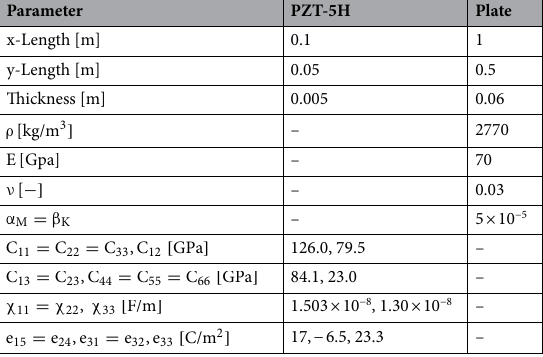
Table 1. Geometrical and physical data of the plate with the piezoelectric patches 27 .